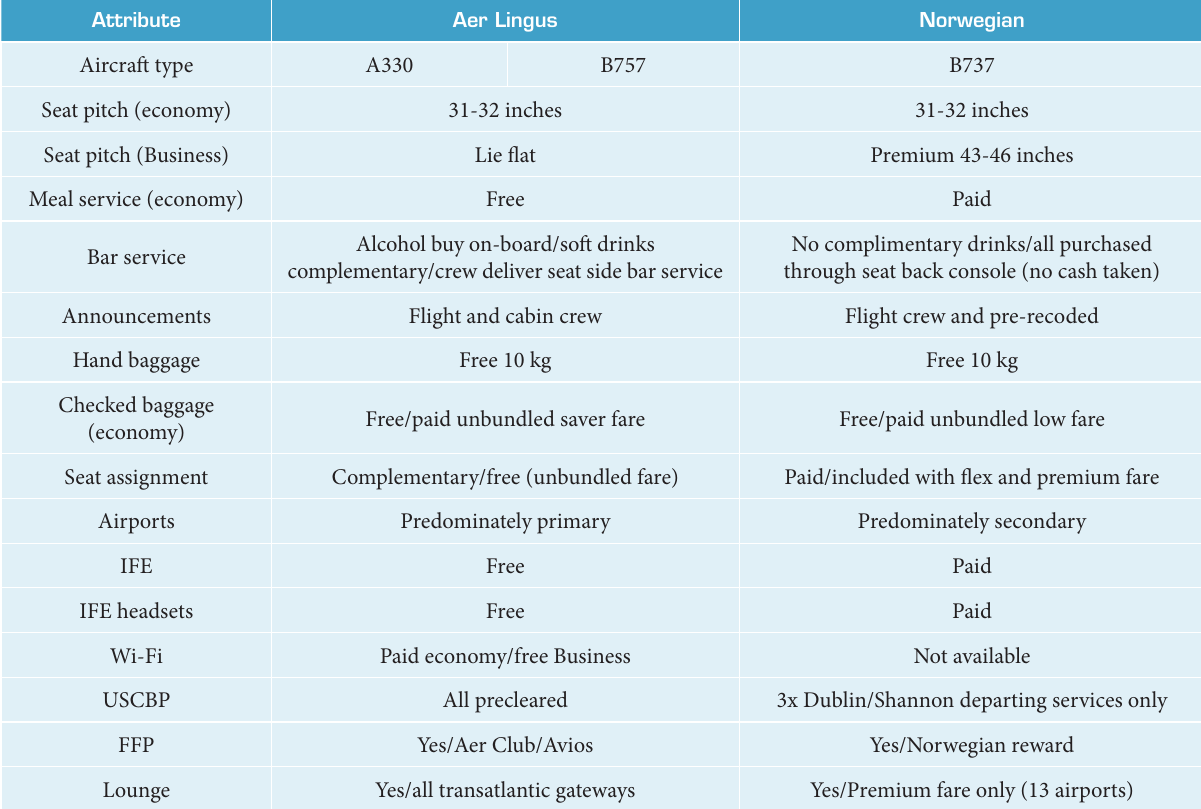
Table 1. Aer Lingus and Norwegian product